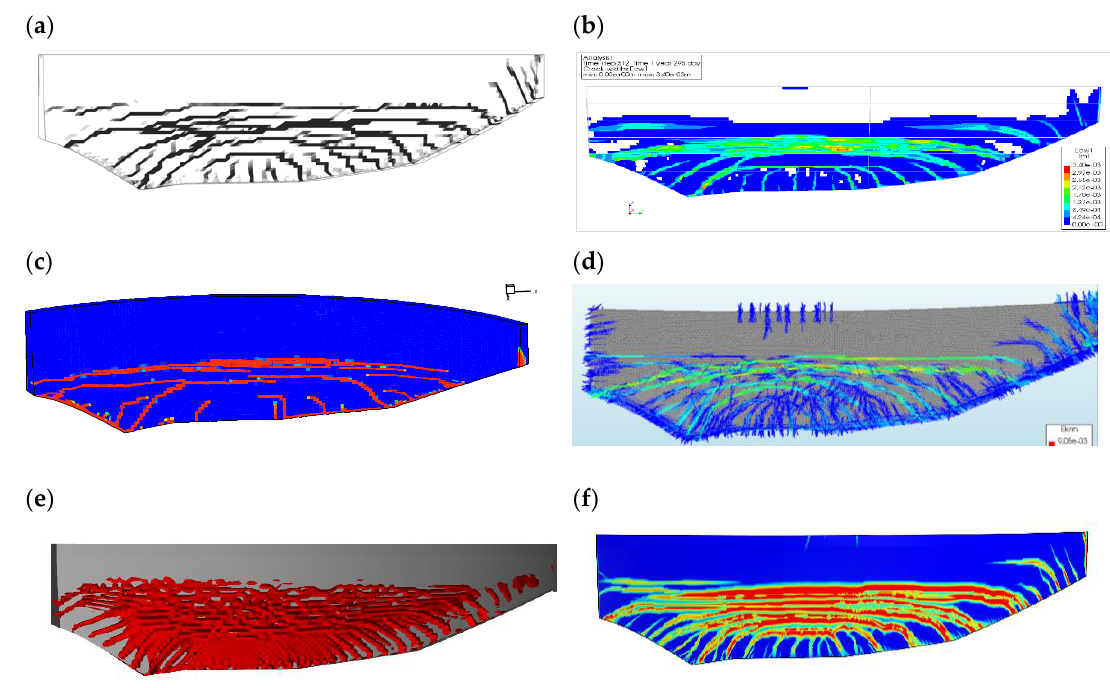
Figure 9. Example of an illustration of the predicted extent of cracking due to extreme temperatures from the following contributors: ( a ) No. 4, ( b ) No. 13, ( c ) No. 8, ( d ) No. 12, ( e ) No. 16, ( f ) No. 6.